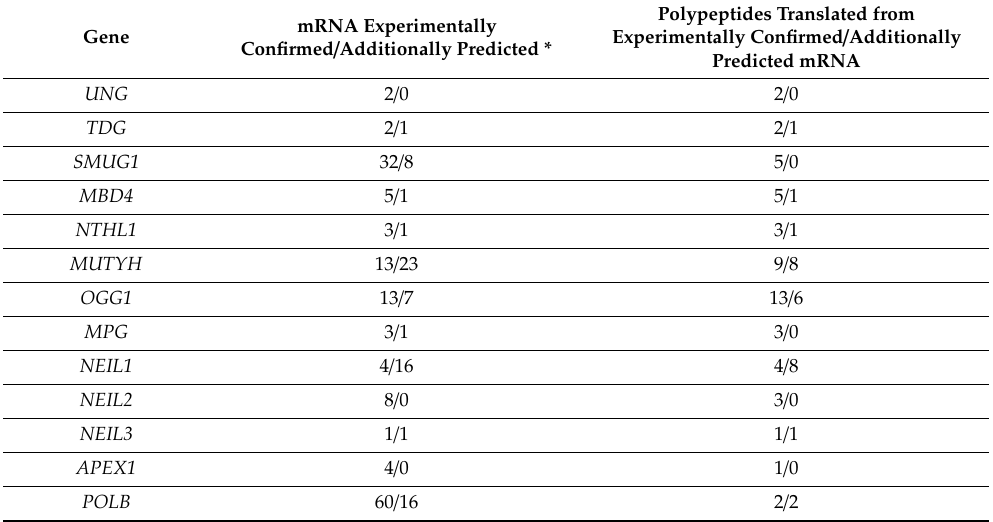
Table 1. Experimentally confirmed and predicted mRNA and protein isoforms of major BER genes. Polypeptides Translated from mRNA Experimentally Gene Experimentally Confirmed / Additionally Confirmed / Additionally Predicted * Predicted mRNA UNG 2 / 0 2 / 0 TDG 2 / 1 2 / 1 32 / 8 5 /